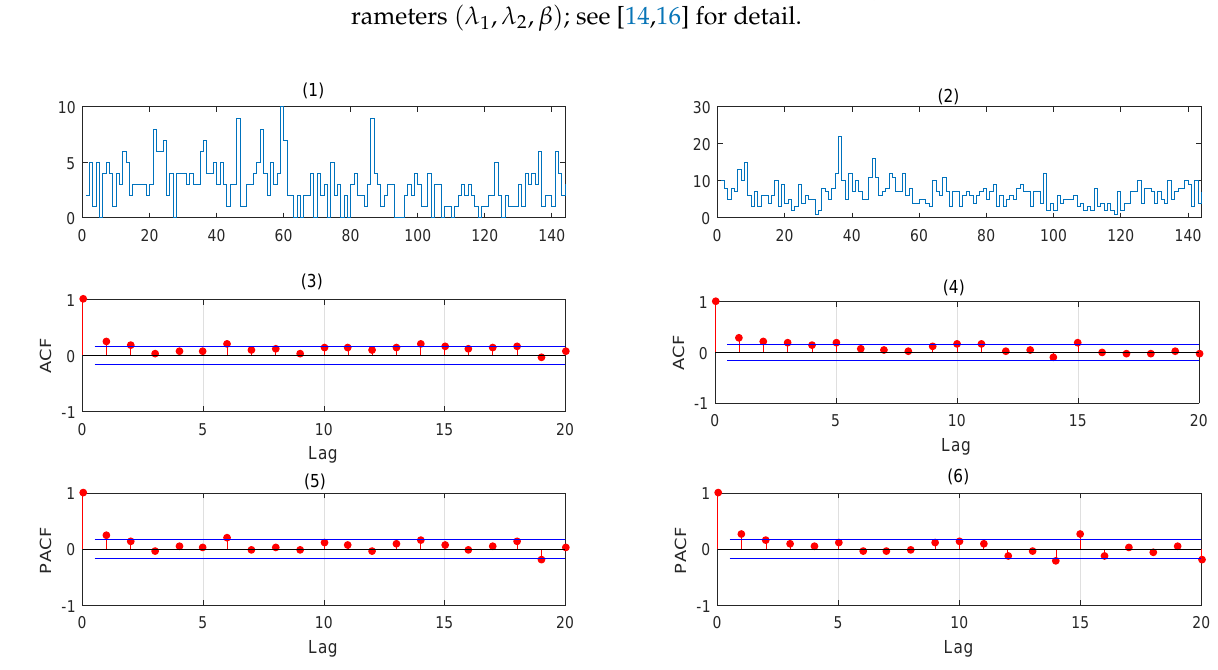
Figure 4. Beat 11: ( 1 ) monthly number of burglary, ( 2 ) monthly number of CMIS, ( 3 ) ACF of burglary, ( 4 ) ACF of CMIS, ( 5 ) PACF of burglary, ( 6 ) PACF of CMIS. As the goodness-of-fit criteria, we use the Akaike information criterion (AIC), the Bayesian information criterion (BIC) and the mean square error of the Pearson residuals Z 2 (PRMS), which is equal to ∑ n / ( n − p ∗ ) , where p ∗ denotes the number of estimated t = 1 t parameters and Z t denotes standardized Pearson residuals.